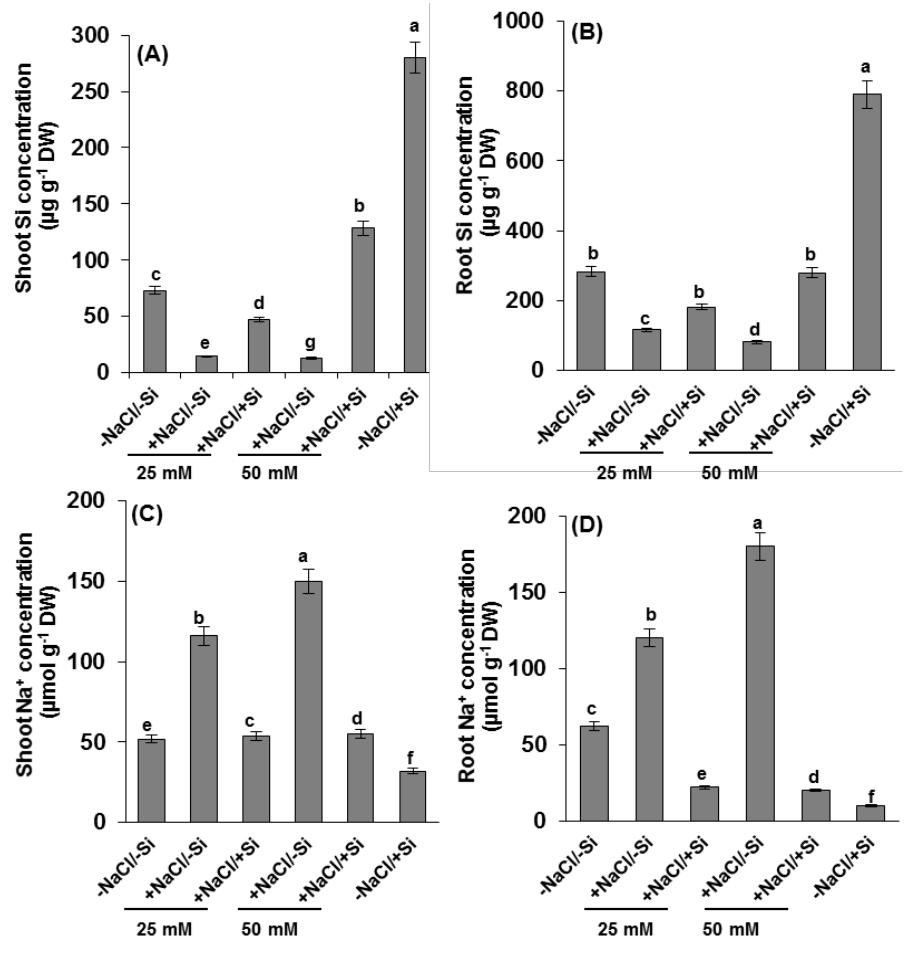
Figure 3. Changes in concentration of ( A , B ) silicon (Si) and ( C , D ) Na + ions in roots and shoots of tomato ( Solanum lycopersicum L.) as affected by NaCl/Si combined treatments along with Control [−NaCl/−Si]: −Si with NaCl [25 mM, +NaCl/−Si], +Si with NaCl [25 mM, +NaCl/+Si], −Si with NaCl [50 mM, +NaCl/−Si], +Si with NaCl [50 mM, +NaCl/+Si] and with additional control +Si without NaCl [−NaCl/+Si]. Vertical bars indicate ± S.E. of the means for n = 5. Means denoted by the different letter are significantly different at p < 0.05 according to the Tukey’s studentized range